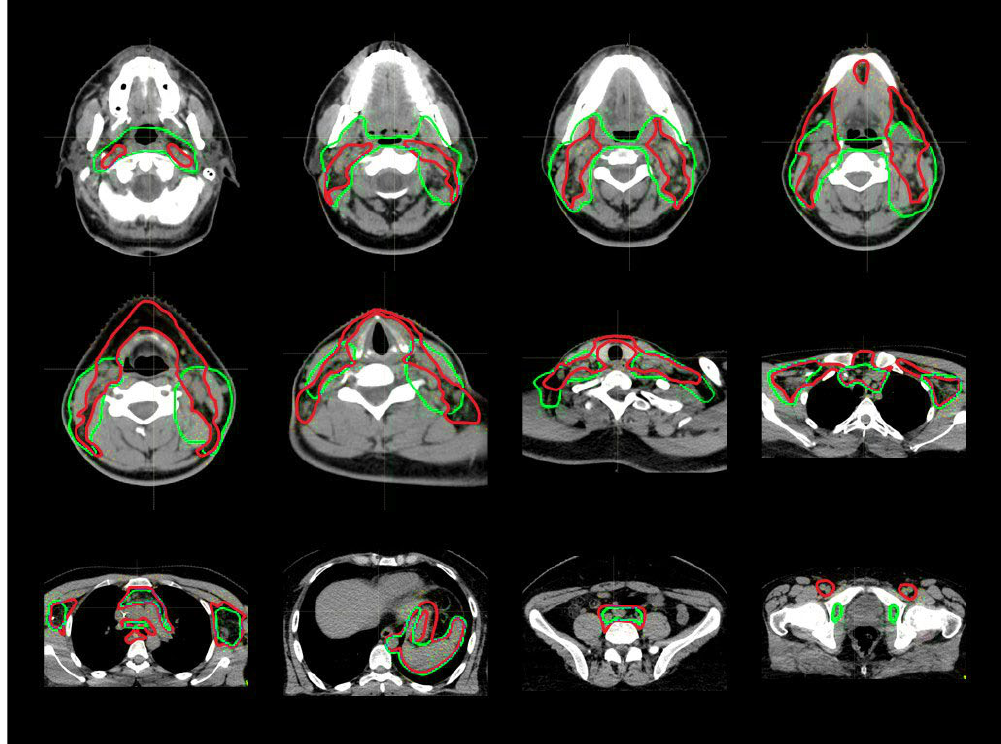
Figure 1. Axial view of CTV_LN contouring for every anatomical district, before (green segmentation) and after (red segmentation) the guidelines’ introduction.